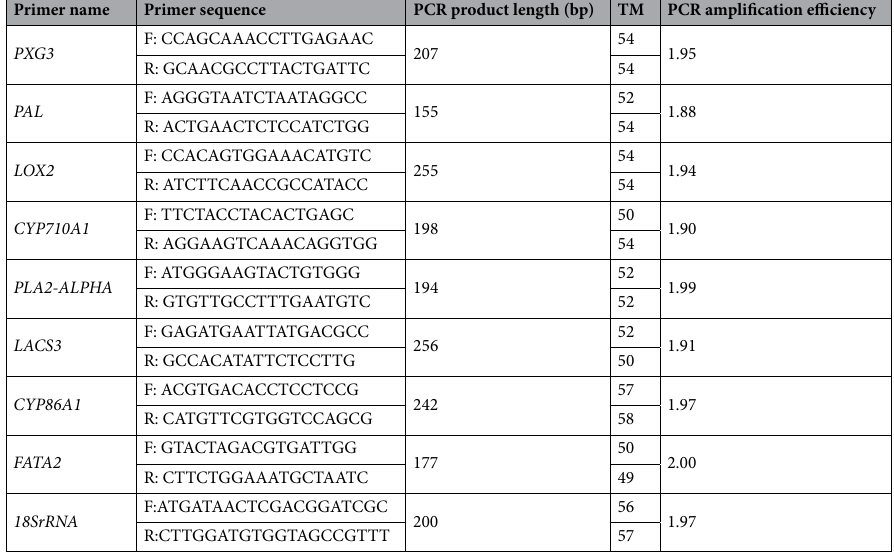
Table 2. RT-qPCR primer sequence of selected candidate and reference genes and their amplification